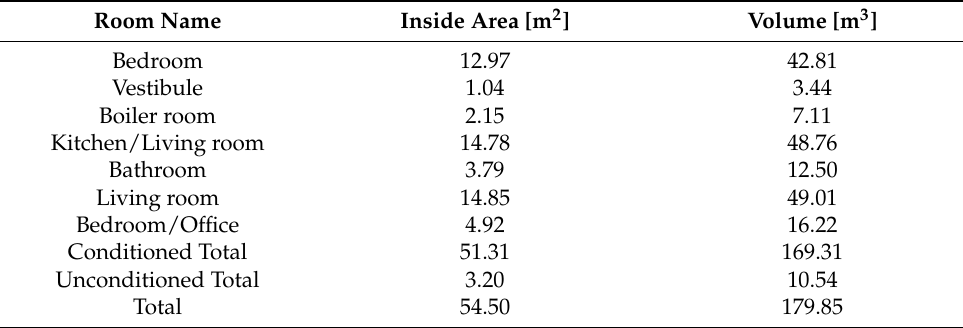
Figure 1. View of the modular building (horizontal cross-section) designed by the author. Table 1. The area and volume of the rooms included in the modular